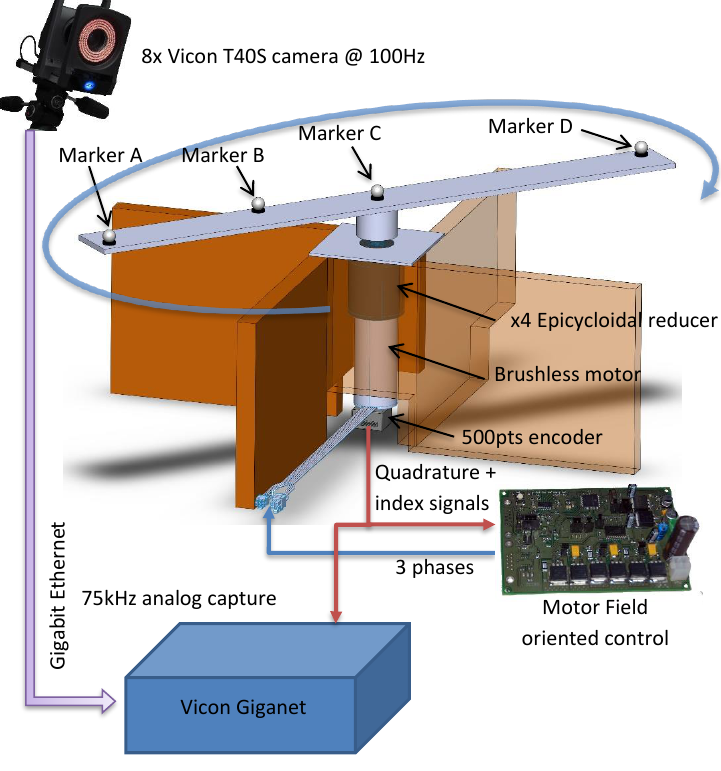
Figure 2. Rotor used in the dynamic